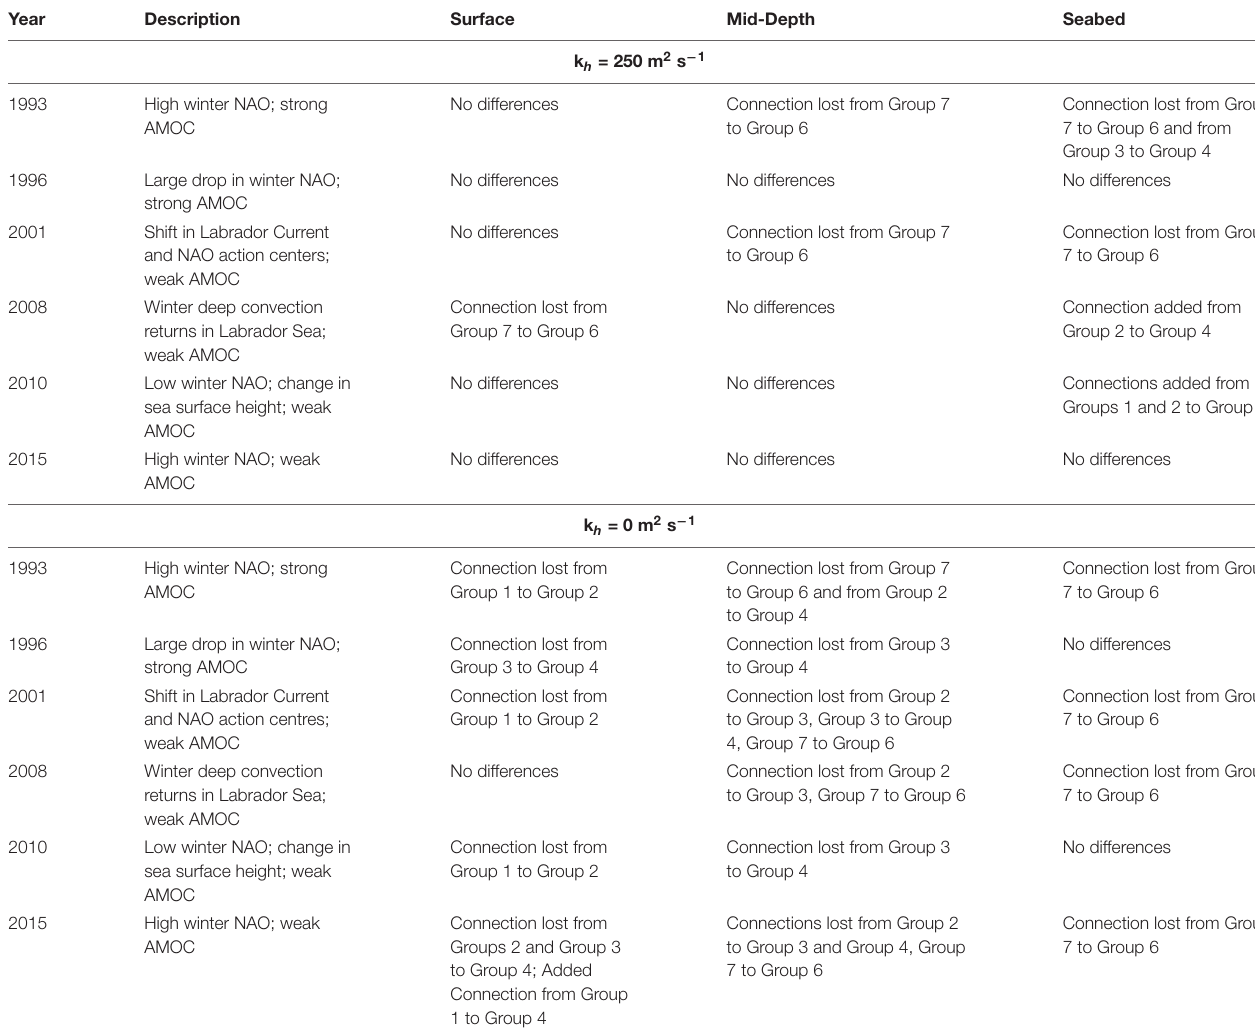
TABLE 4 | Comparison of connectivity patterns from three release depths between results utilizing July long-term averaged currents, with those found in the same month in each of six individual years, that is monthly averaged currents within selected years (differences documented relative to the former; differences in retention not